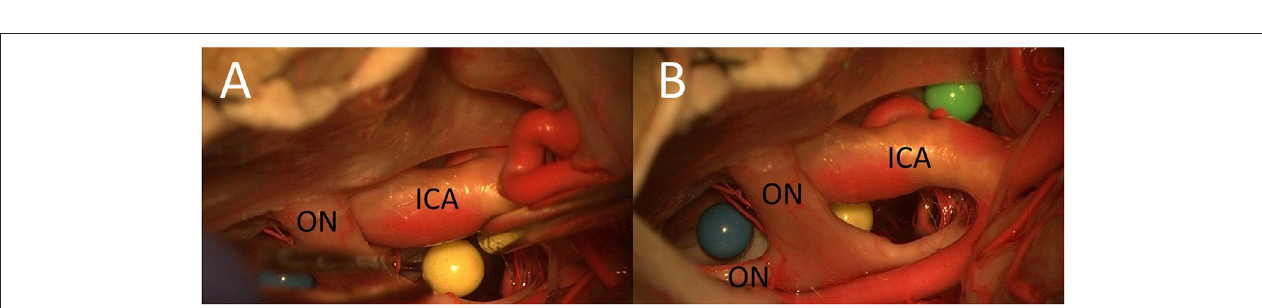
FIGURE 2 | Placement of artificial lesions (three colored spheres) in key locations (A,B) (ON, optic nerve).